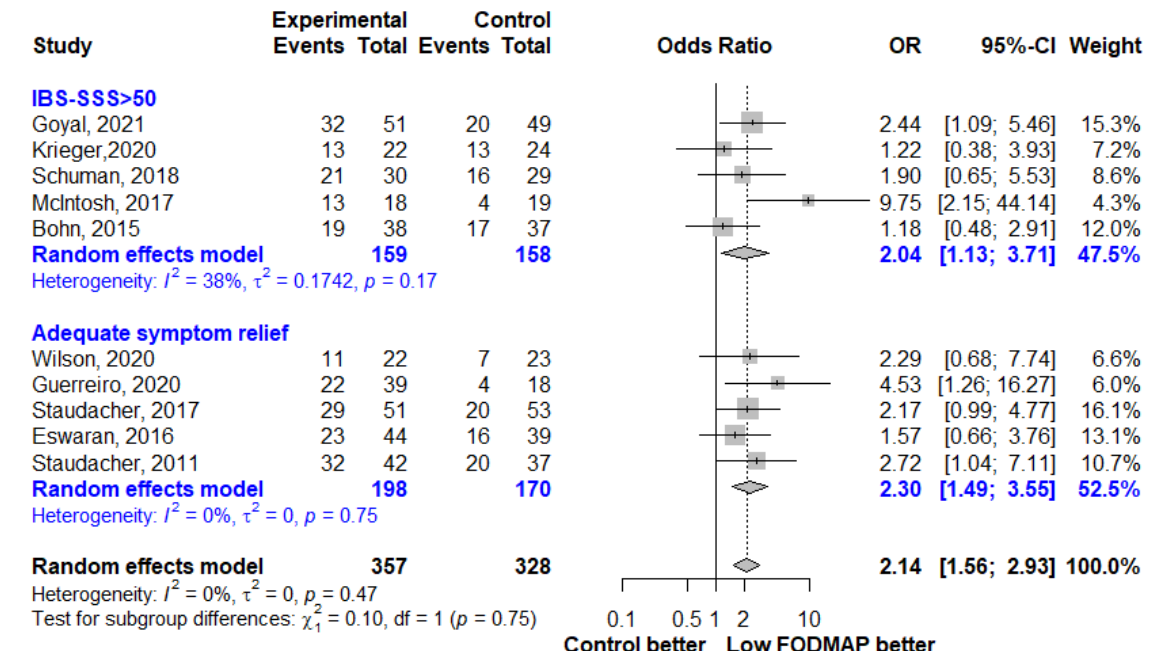
Figure 3. Forest plot showing mean IBS ‐ SSS reduction in studies that used pre ‐ and post ‐ intervention IBS ‐ SSS measures. SD, standard deviation; MD, mean difference; CI, confidence interval .